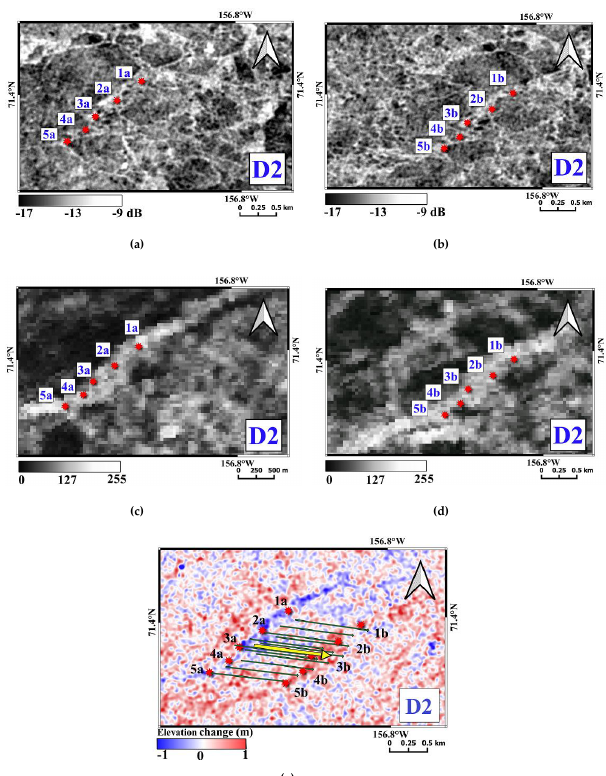
Figure 8. Displacement D2: SAR backscatter intensity on 13 Jan ( a ) and 24 Jan 2012 ( b ). Coastal radar images on 13 Jan ( c ) and 24 Jan 2012 ( d ). The HDM is displayed in ( e ) with individual displacement vectors in green and average displacement vector in yellow. Control points 1a–5a and 1b–5b represent ridge features that can be recognized before and after the